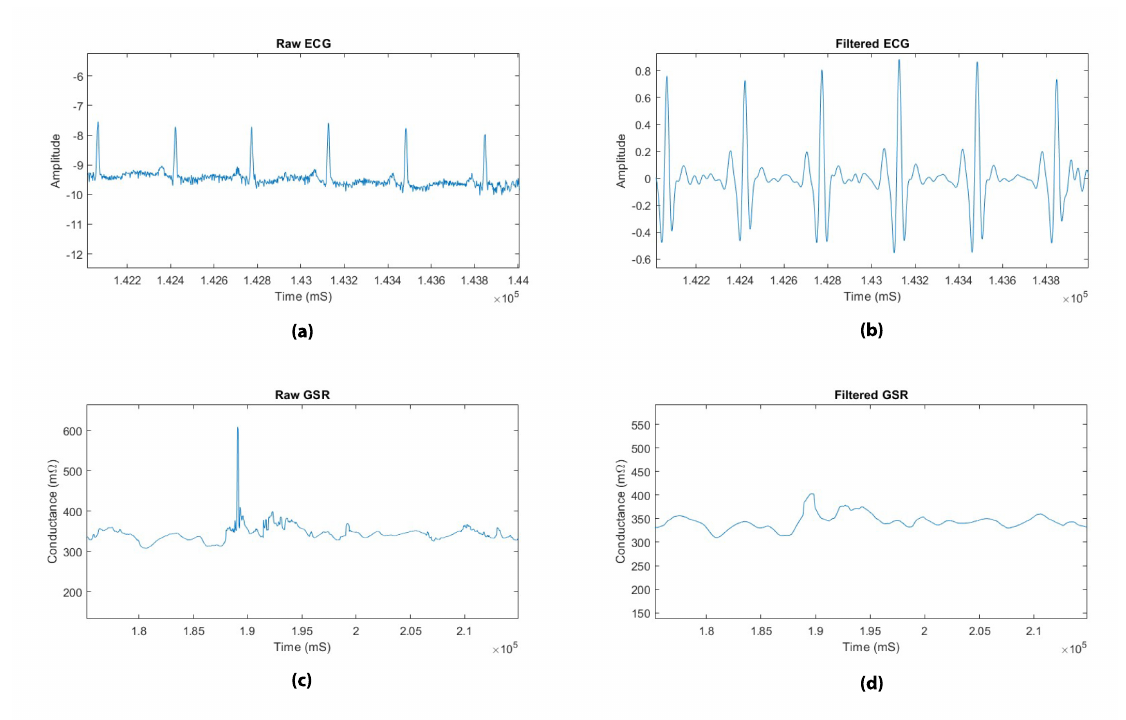
Figure 3. Examples of: ( a ) Raw electrocardiogram (ECG) signal; ( b ) Filtered ECG signal; (ECG) ( c ) Raw galvanic skin response (GSR) signal; ( d ) Filtered GSR